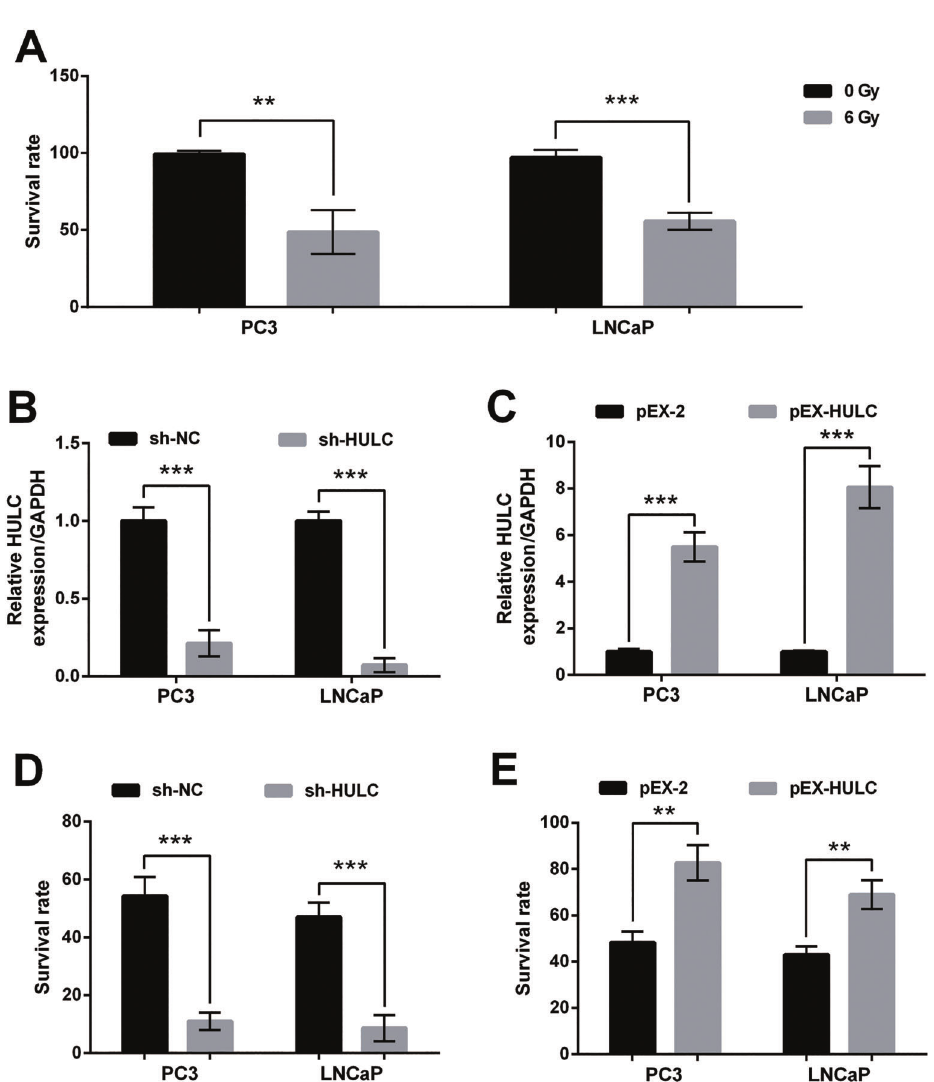
Figure 1. HULC knockdown enhanced the sensitivity of PC3 and LNCaP cells to irradiation. A , Survival rate was reduced by irradiation. B , HULC was down-regulated by sh-HULC. C , HULC was up-regulated by pEX-HULC. D , Survival rate after irradiation was further reduced by HULC knockdown. E , Survival rate after irradiation was increased by HULC overexpression. Data are reported as means ± SD. **P o 0.01; ***P o 0.001 ( t -test). HULC: long non-coding RNA highly upregulated in liver cancer; sh-HULC: pGPU6/GFP/Neo plasmid carrying short-hairpin RNA targeting HULC; sh-NC: pGPU6/GFP/Neo plasmid carrying a non-targeting RNA; pEX-HULC: pEX-2 plasmid carrying full-length